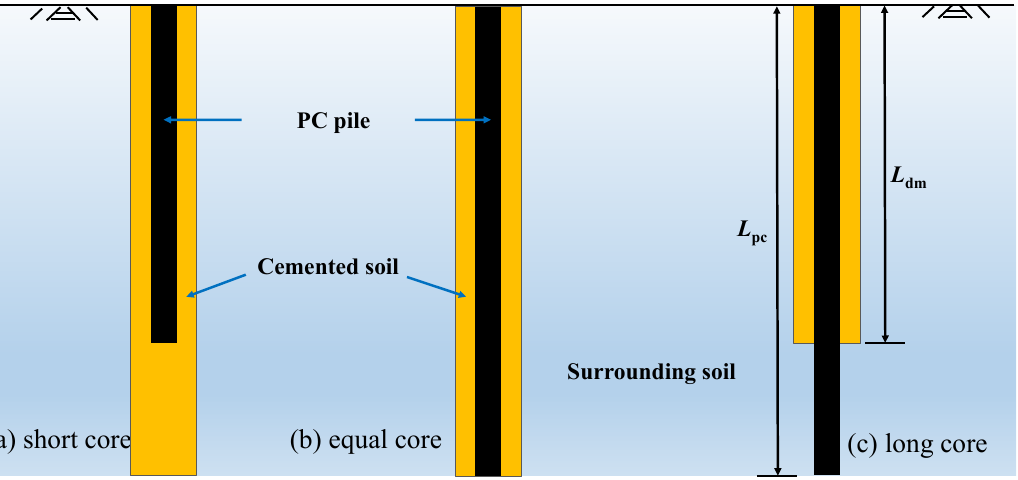
Figure 1. Schematic diagram of the SDM column.